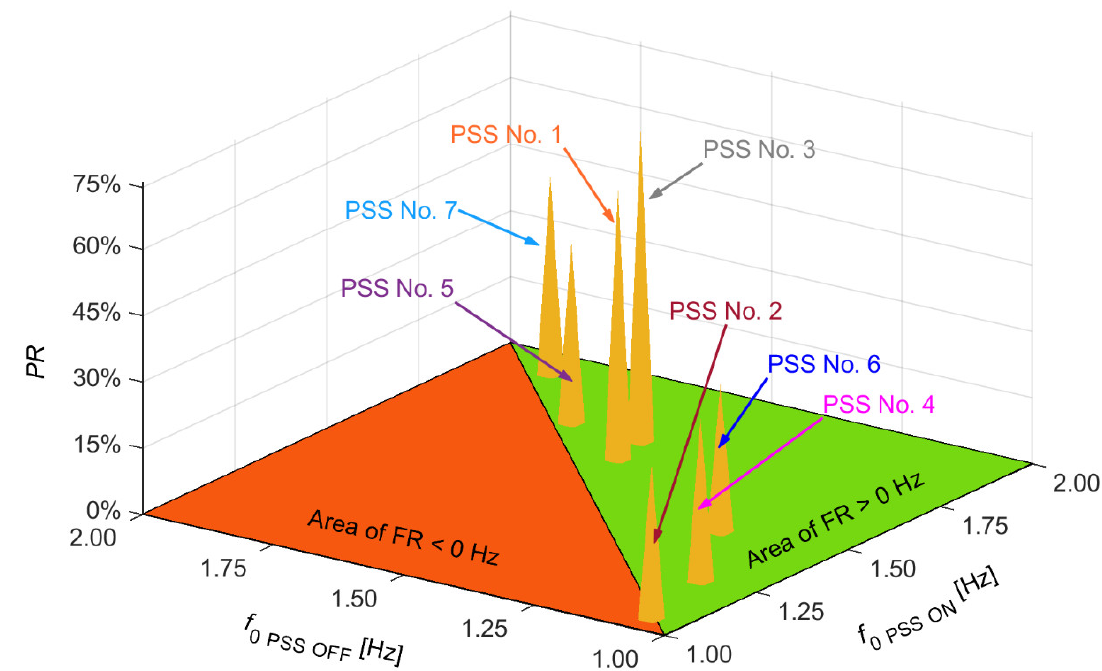
Figure 20. A 3D presentation of the PR indices from Table 3 plotted on the f 0 PSS ON − f 0 PSS OFF plane.